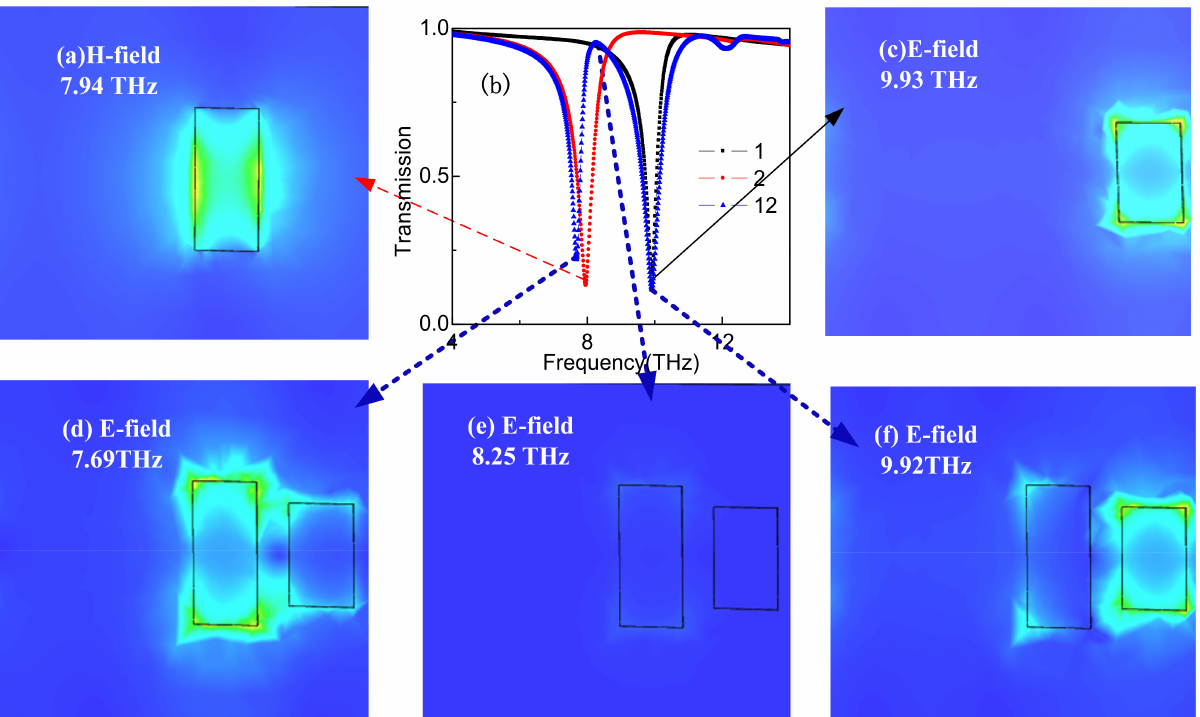
Figure 6. ( a ) magnetic field distribution, ( b ) The transmission spectra, and ( c – f ) electric field distribution of transmission spectra on normal